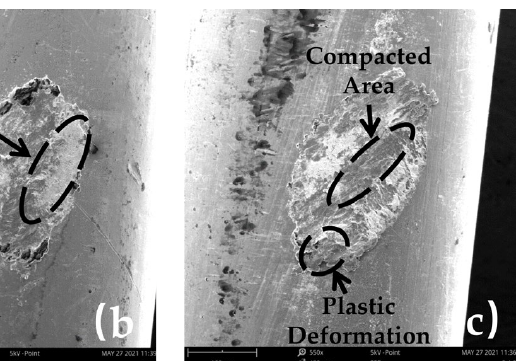
Figure 7. SEM images of worn surface under different crossing angles and temperatures: ( a ) 20 °C— 30° ; ( b ) 200 °C— 30° ; ( c ) 400 °C— 30° ; ( d ) 20 °C— 60° ; ( e ) 200 °C— 60° ; ( f ) 400 °C— 60° ; ( g ) 20 °C— 90° ; ( h ) 200 °C— 90° ;( i ) 400 °C— 90° .